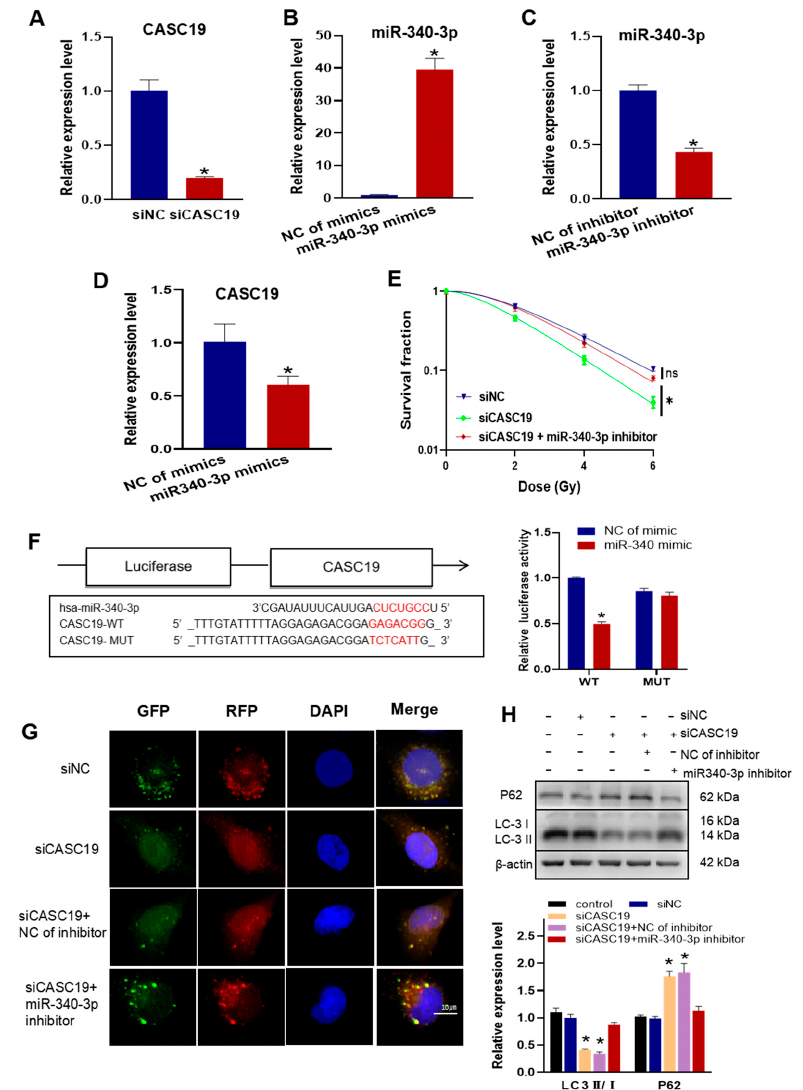
Figure 4. CASC19 enhanced autophagy and promoted the radioresistance of NPC by negatively regulating miR-340-3p: ( A ) verification of the interference efficiency of CASC19 smart silencer (siCASC19) in CNE2R cells; ( B , C ) the expression of miR-340-3p in CNE2R cells after transfection of miR-340-3p mimics ( B ) or miR-340-3p inhibitor ( C ); ( D ) the expression of CASC19 in CNE2R cells after transfection of miR-340 mimics; ( E ) survival curves of irradiated CNE2R cells transfected with siCASC19, miR-340 inhibitor, or its control; ( F ) prediction of the target binding sites of CASC19 and miR-340-3p was verified using the dual-luciferase reporter assay; ( G ) autophagy assay using mRFP-GFP-LC3 in CNE2R cells transfected with siCASC19, miR-340 inhibitor, or their controls; ( H ) Western blot assay of P62 and LC3 proteins in CNE2R cells transfected with siCASC19, miR-340 inhibitor, or their controls. * p < 0.05 compared with corresponding control or between indicated groups.